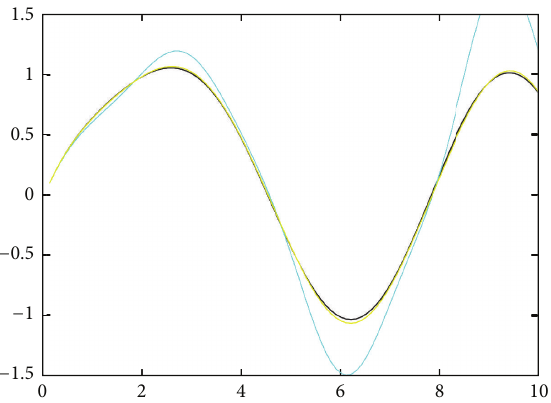
Figure 10: Comparison of real solution (black) and symbolic solutions for 𝑚 = 10 (light blue line) and 𝑚 = 100 (yellow line).